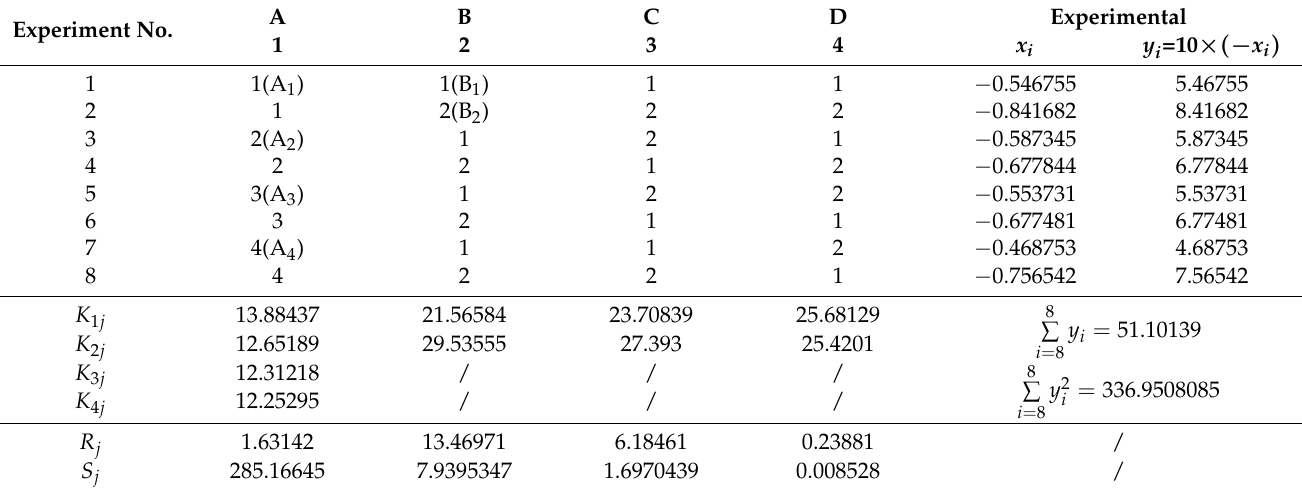
Table 5. Experimental results and calculations of the joint model at 10 MHz incident wave.